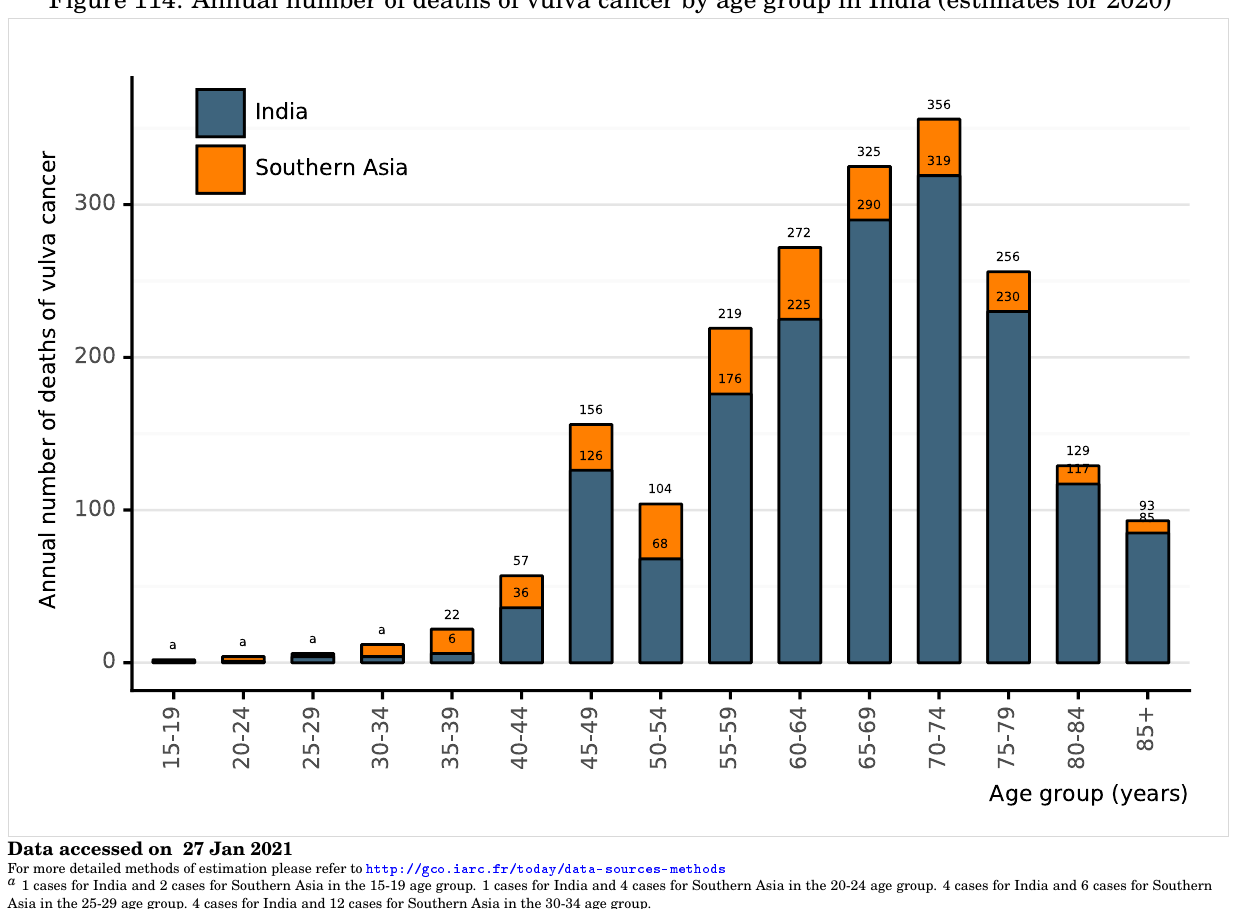
Figure 114: Annual number of deaths of vulva cancer by age group in India (estimates for